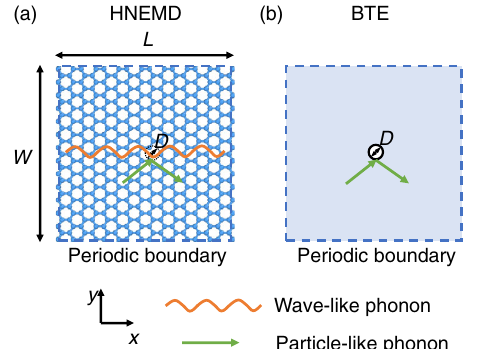
Fig. 1 The schematic of isolating wave-like and particle-like thermal transport by comparing HNEMD and phonon BTE simulation. a The setup of HNEMD simulation. b The setup of phonon BTE calculation. Periodic boundary conditions are applied to x -directional and y -directional boundaries in both HNEMD and BTE. In BTE, the boundary of the pore is set as a diffusely re fl ecting boundary. D denotes the diameter of the pore. The number of absent atoms of the pore is denoted as N . L and W denote the domain length and width, respectively. The temperature is set as 300 K. The thermal conductivity is along the y